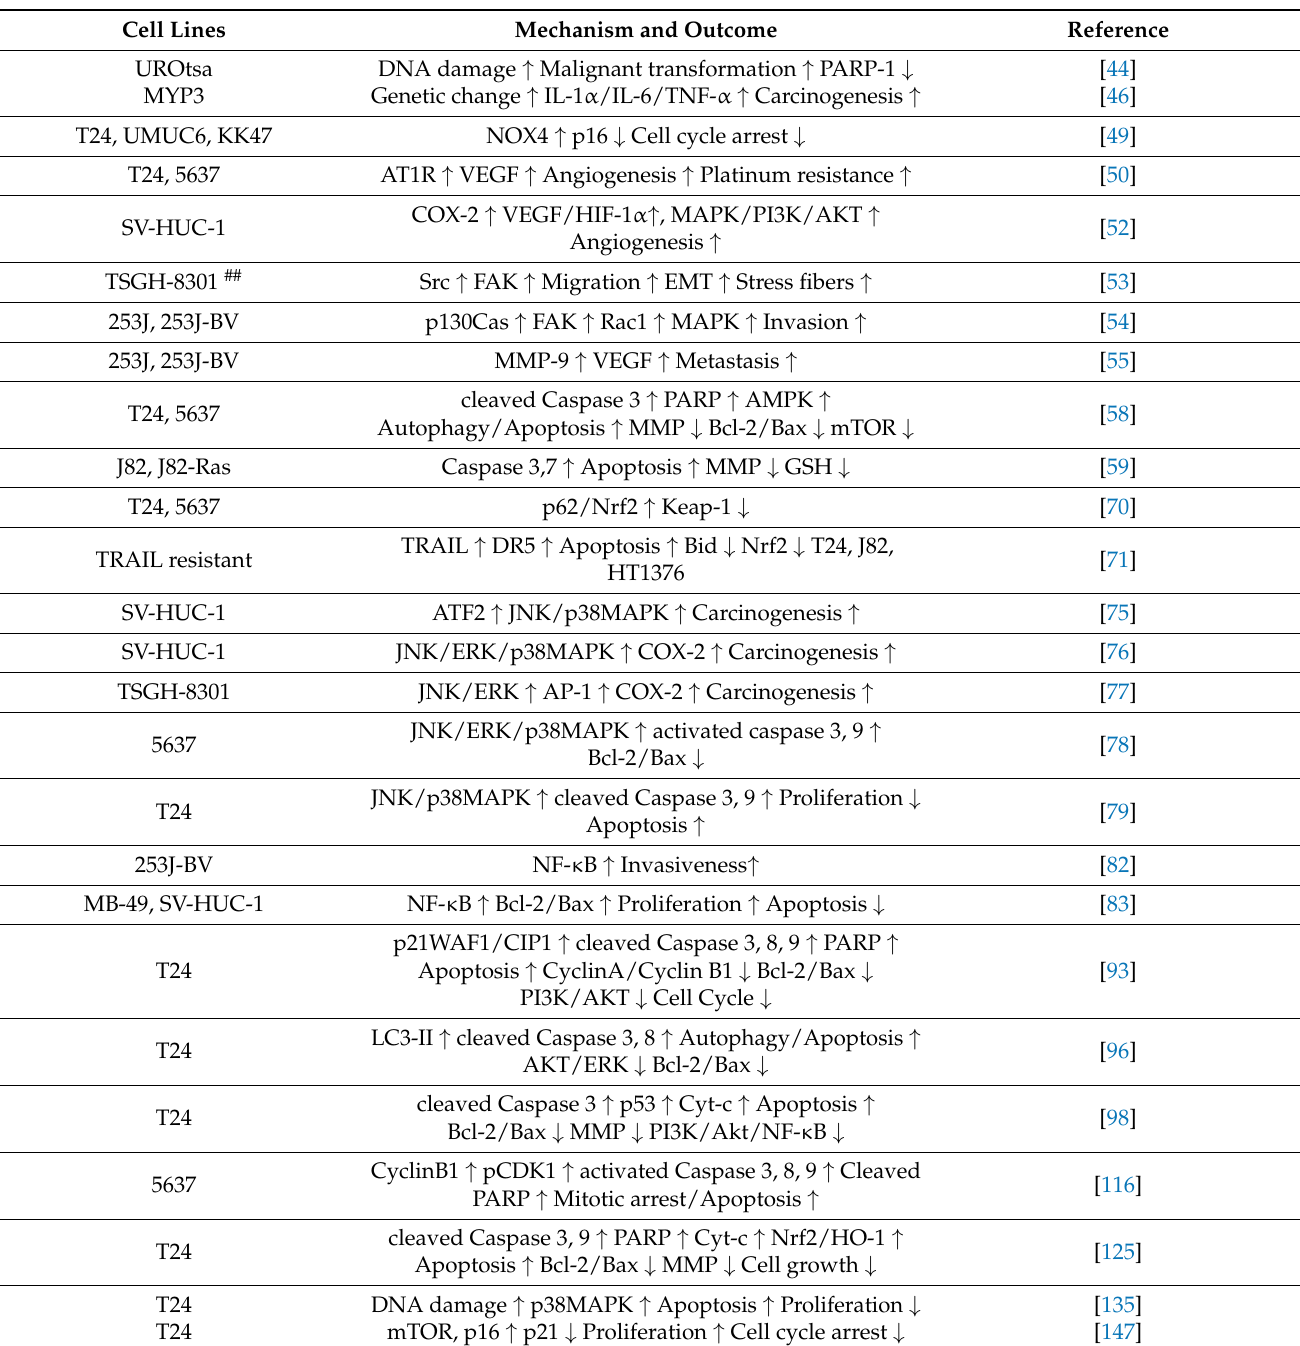
Table 1. Effects of ROS on bladder cancer #